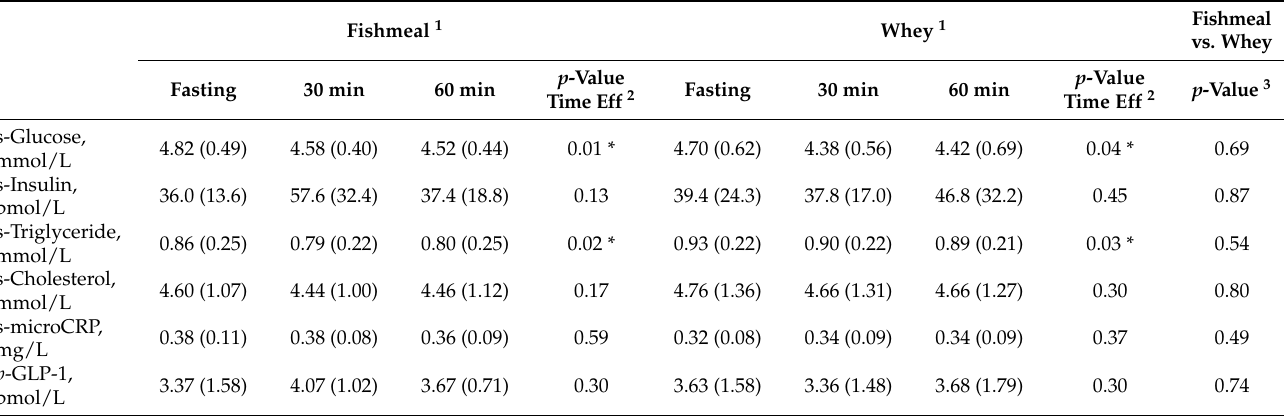
Table 3. Concentrations of metabolic markers, GLP-1 and microCRP in blood. Fishmeal 1 Whey 1